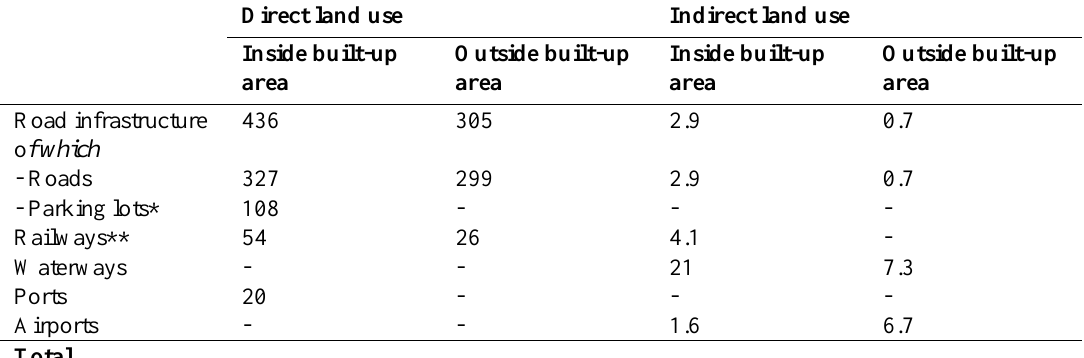
Table 7. Overview of interest costs of land use by infrastructure (in mln Euro per year) Direct land